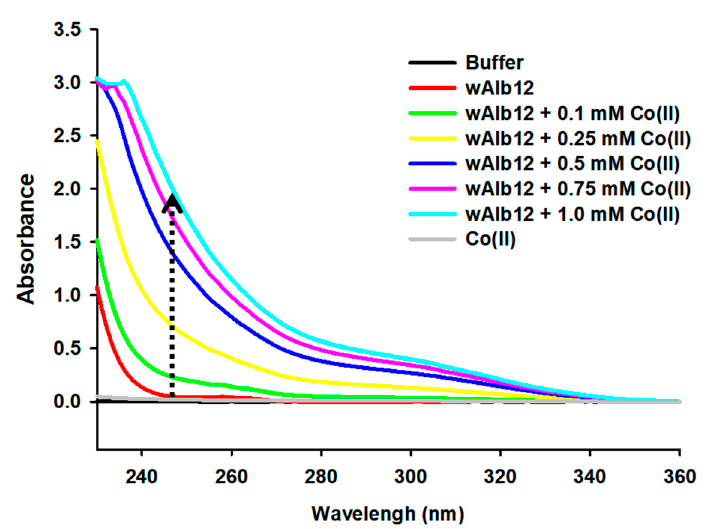
Figure 2. Change in the UV spectrum of 0.5 mM wAlb12 by Co(II) binding at wavelengths between 230–360 nm.